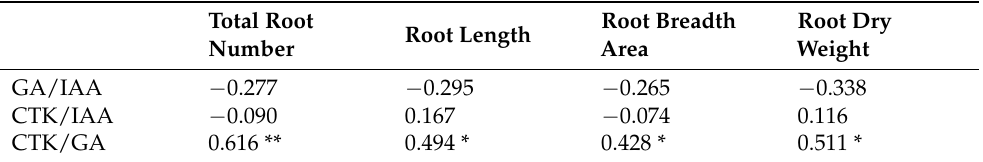
Table 6. Pearson’s correlation coefficients and their statistical significance of endogenous hormones ratio and root physical traits.